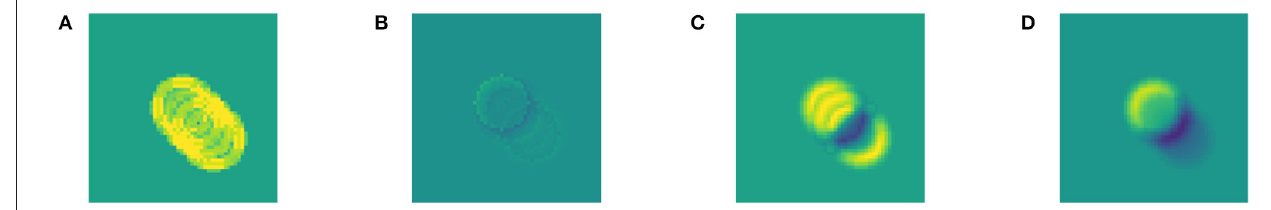
). (B) Spatio-temporal Avg Pool (ST-AVG= AP V ST